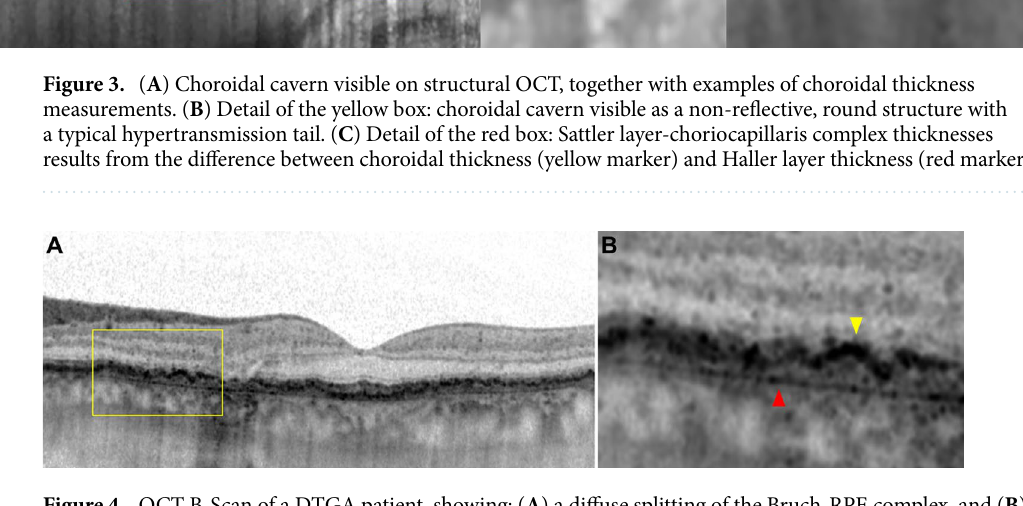
Figure 4. OCT B-Scan of a DTGA patient, showing: ( A ) a diffuse splitting of the Bruch-RPE complex, and ( B ) close-up of yellow box, with Bruch’s membrane (red arrow) and RPE (yellow